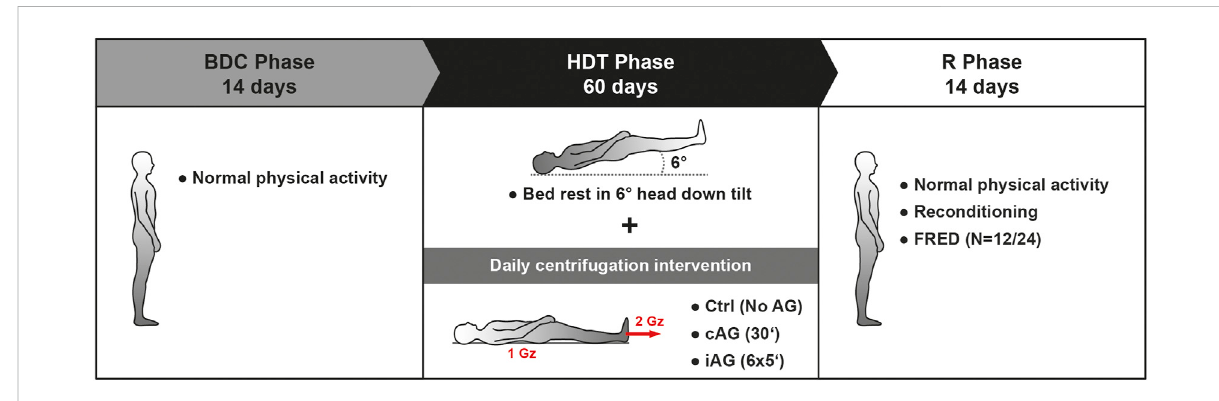
FIGURE 1 Schematic representation of the AGBRESA study design. FRED is a functional re-adaptive exercise device (Debuse et al., 2013) used during the recovery phase. Ctrl: control group, no centrifugation; cAG: continuous centrifugation for 30 min; iAG intermittent centrifugation for 6 × 5